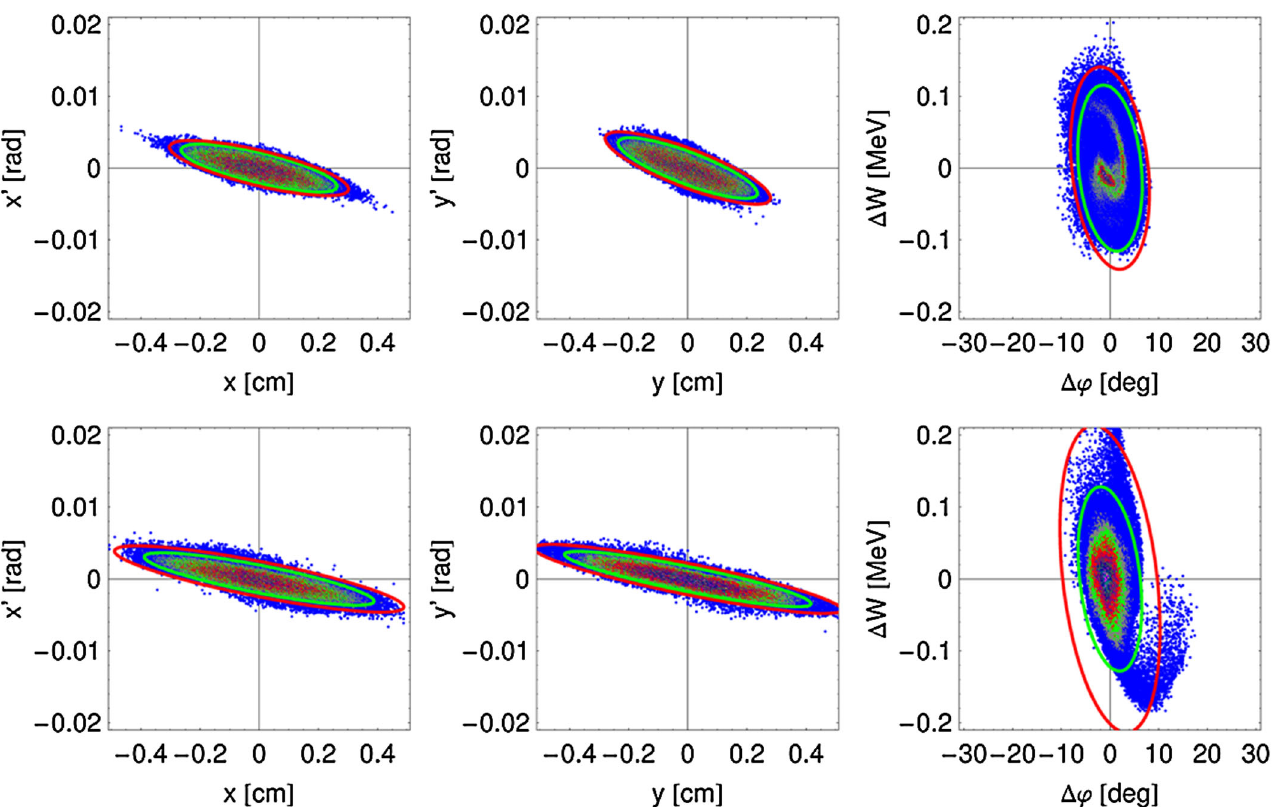
FIG. 13. (Color) Particle distributions at the injector exit with the red and green ellipses for 99% and 95% of transported particles, respectively (top: 5 mA; bottom: 30